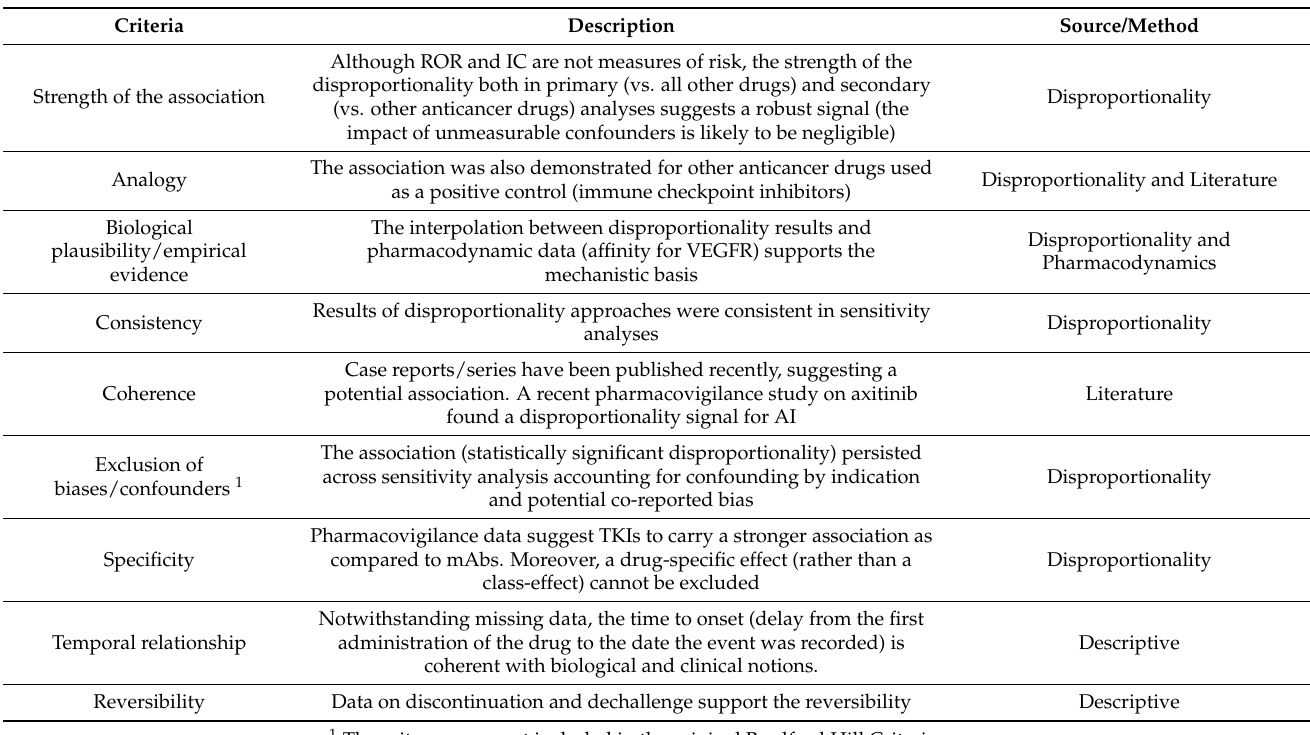
Table 3. Global assessment through adapted Bradford Hill Criteria.